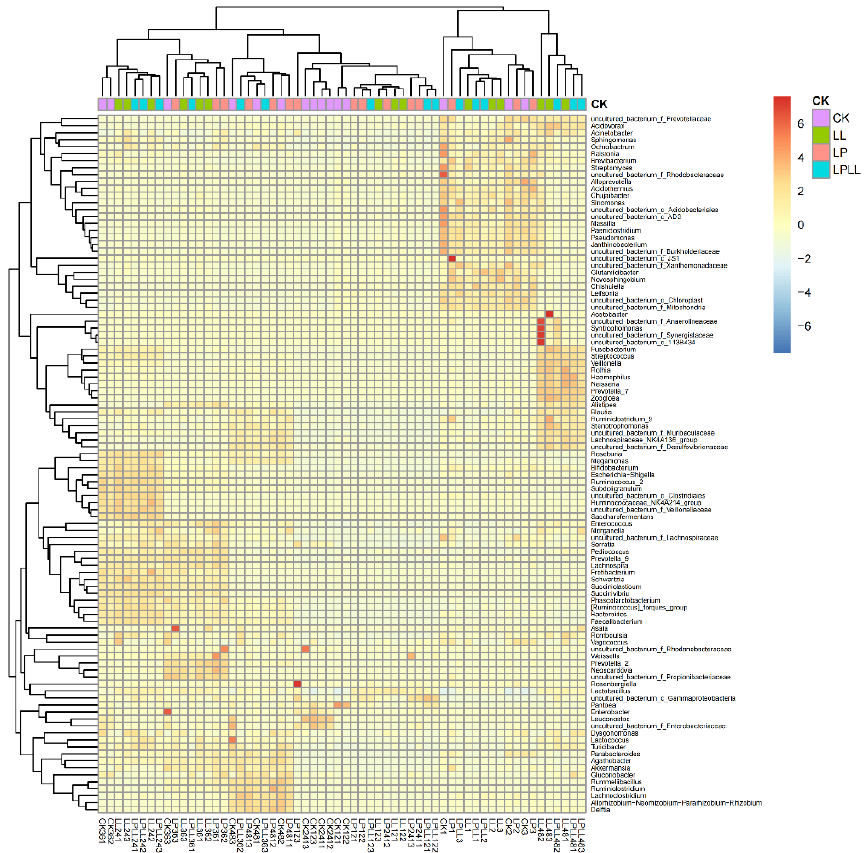
Figure 7. R heat map of fermented sugarcane juice.CK: fresh sugarcane juice; LL: sugarcane juice with added HNK10; LP: sugarcane juice added with HNK21; LPLL: sugarcane juice treated with HNK10 + HNK21 was added.